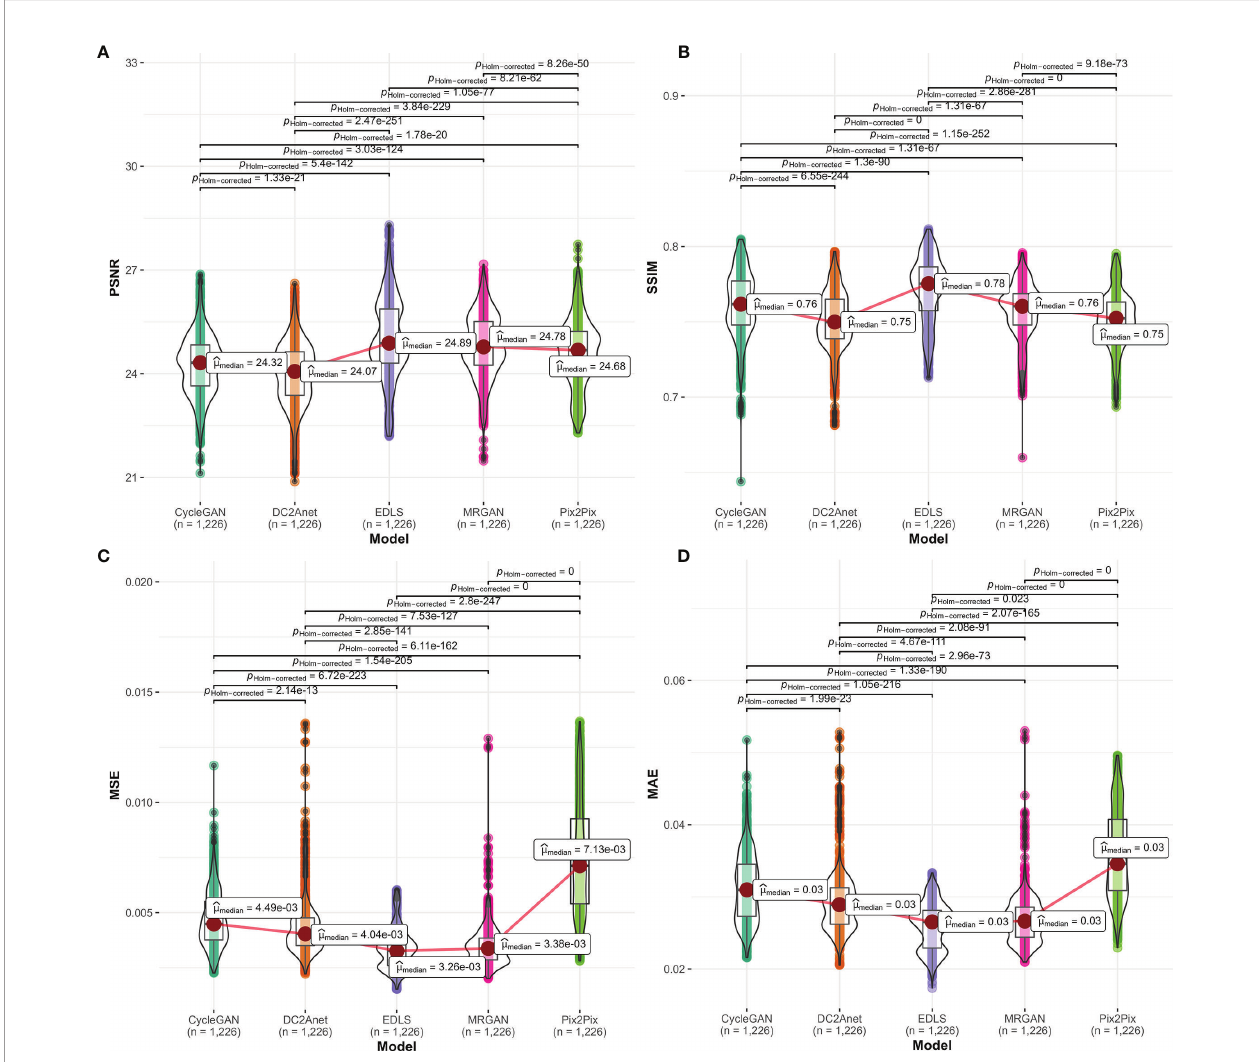
FIGURE 2 | The comparison of the performance between our model and conventional models on (A) PSNR, (B) SSIM, (C) MSE, and (D) MAE metrics. From left to right, the violin plots with a median (orange line) respectively represented CycleGAN, DC2Anet, EDLS, MR-GAN, and